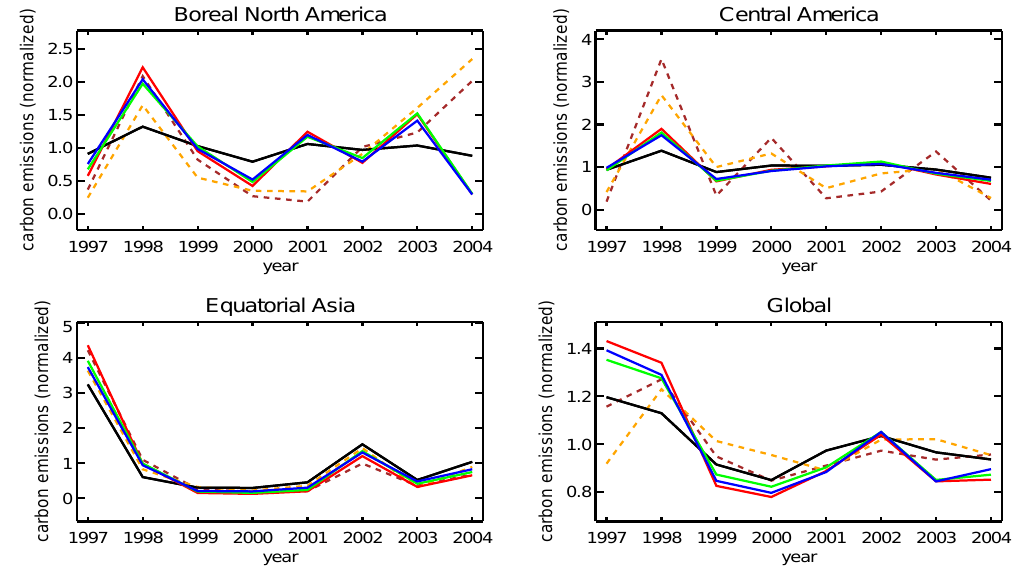
Fig. 5. Annual mean total (wildfire and deforestation) fire carbon emissions normalized by the mean for 1997–2004 for regions characterized by a high interannual variability reported in the satellite-based products and globally. Solid lines represent model simulations: black: T-FULL, red: AB-FULL, green: AB-HI; blue: AB-HI-FS. Dashed lines are observations: brown: GFEDv2 (van der Werf et al., 2006); orange: GICC (Mieville et al., 2010). Correlation coefficients for the interannual variability for different regions are given in Table 4.